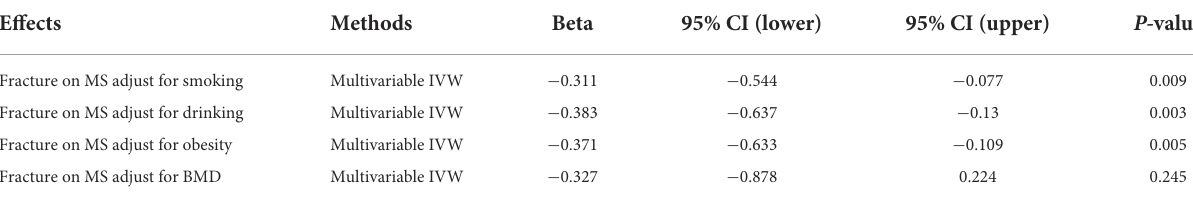
TABLE 5 Multivariable MR analyses of the causal association of fracture on